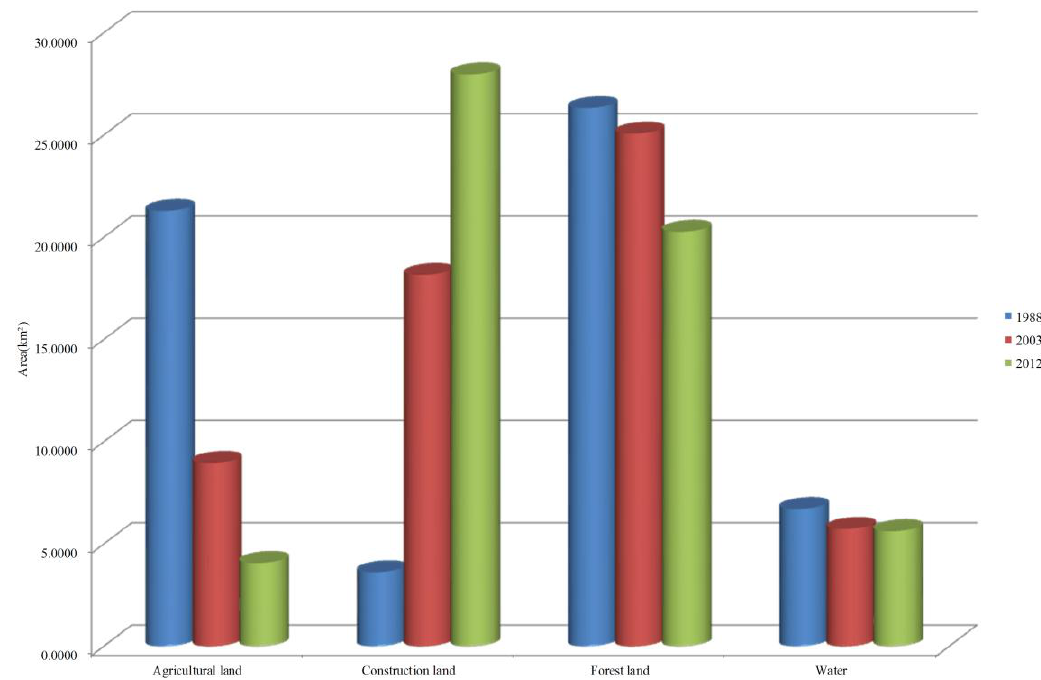
Figure 6. Area of land use classes in the study area.